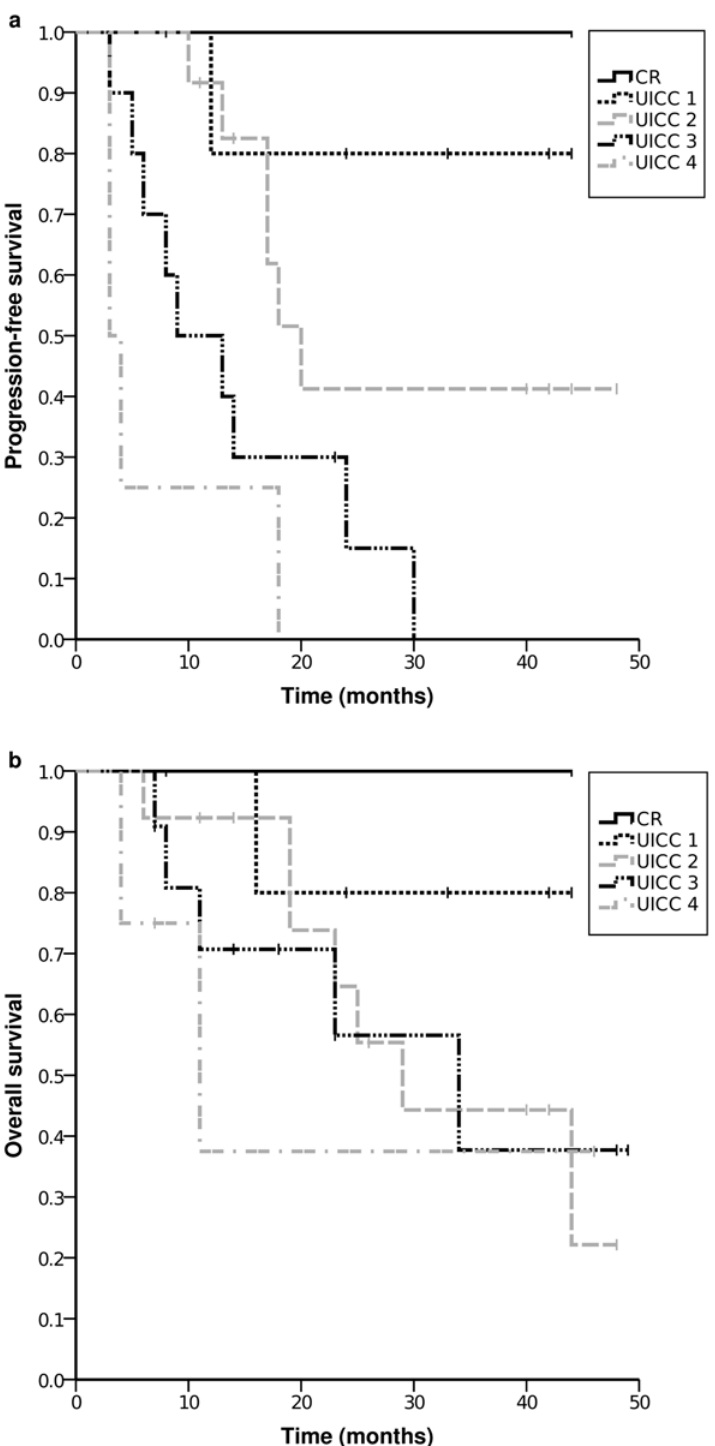
Fig 2. Kaplan-Meier plots of PFS (a) and OS (b) according to postsurgical UICC stages.